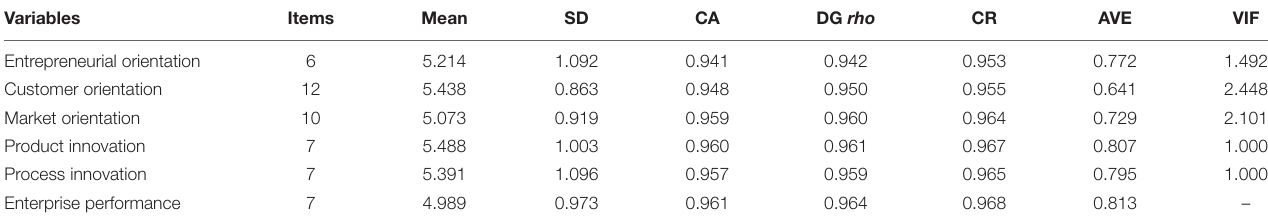
TABLE 1 | Reliability and validity.